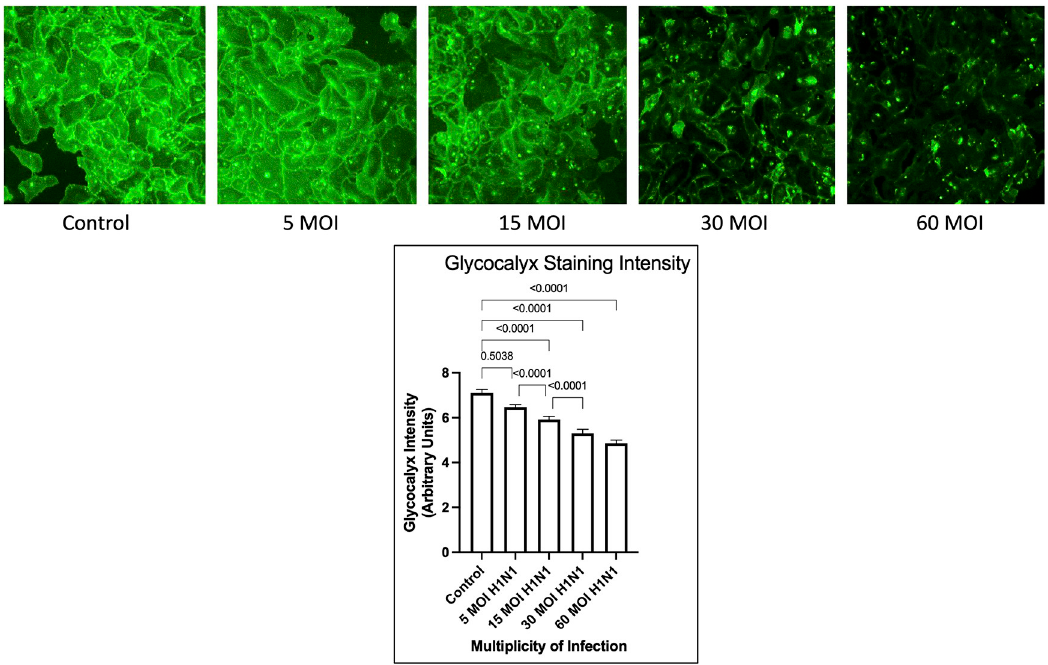
Fig 1. Endothelial glycocalyx staining intensity after H1N1 Infection. A comparison of glycocalyx staining intensity for control and H1N1 influenza virus exposed HUVECs at a multiplicity of infection of 5, 15, 30, and 60 along with representative images.